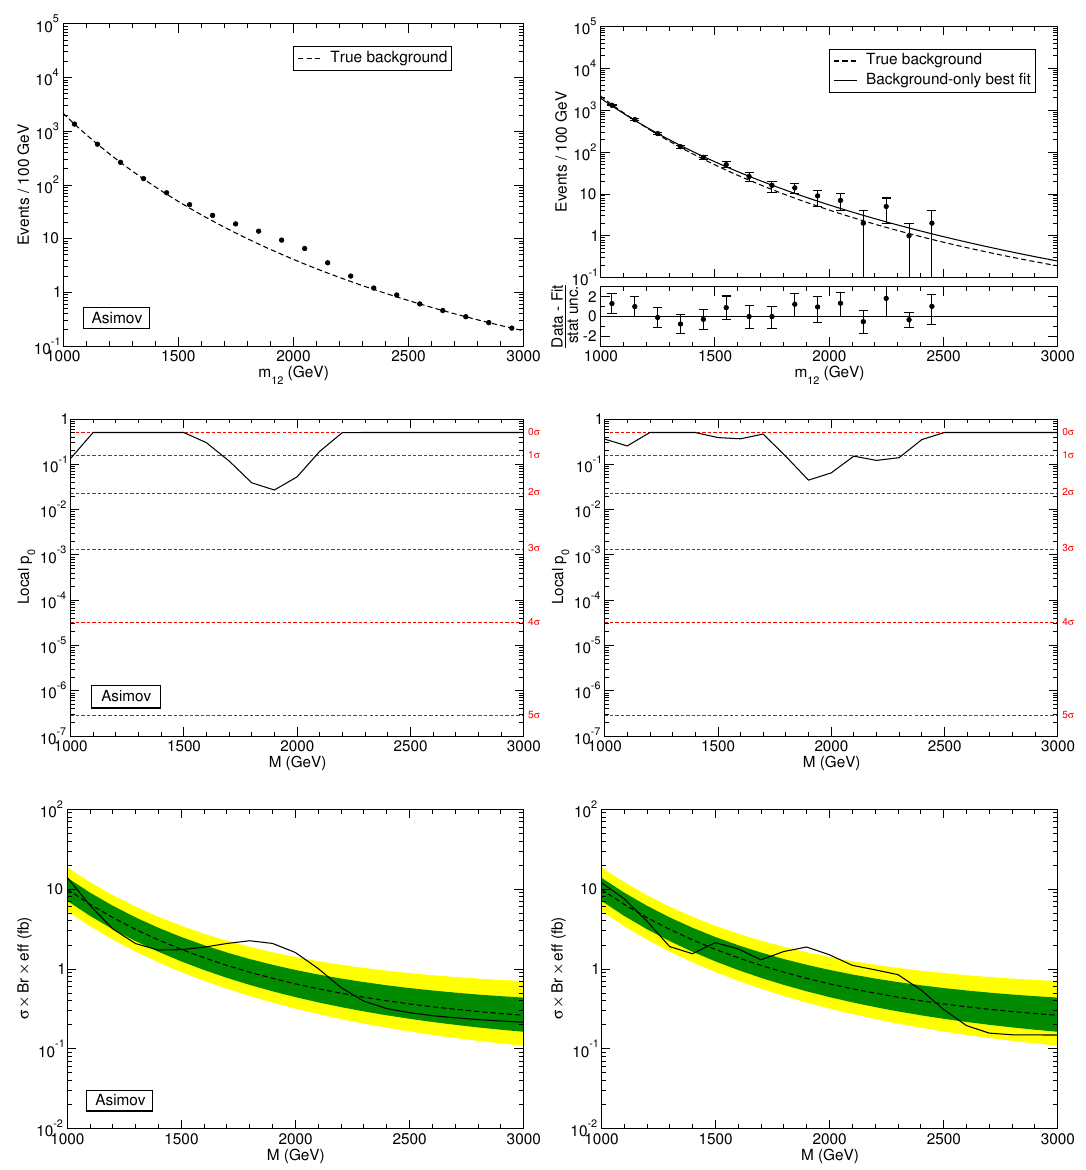
Figure 8 . Top, left: Asimov data for the symmetric triboson bump in (cid:12)gure 4 (left), with a size of 40 signal events. Top, right: data for a pseudo-experiment. Middle, left: local p -values for the Asimov data. Middle, right: local p -values for the pseudo-experiment. Bottom, left: expected and observed limits for the Asimov data. Bottom, right: expected and observed limits for the